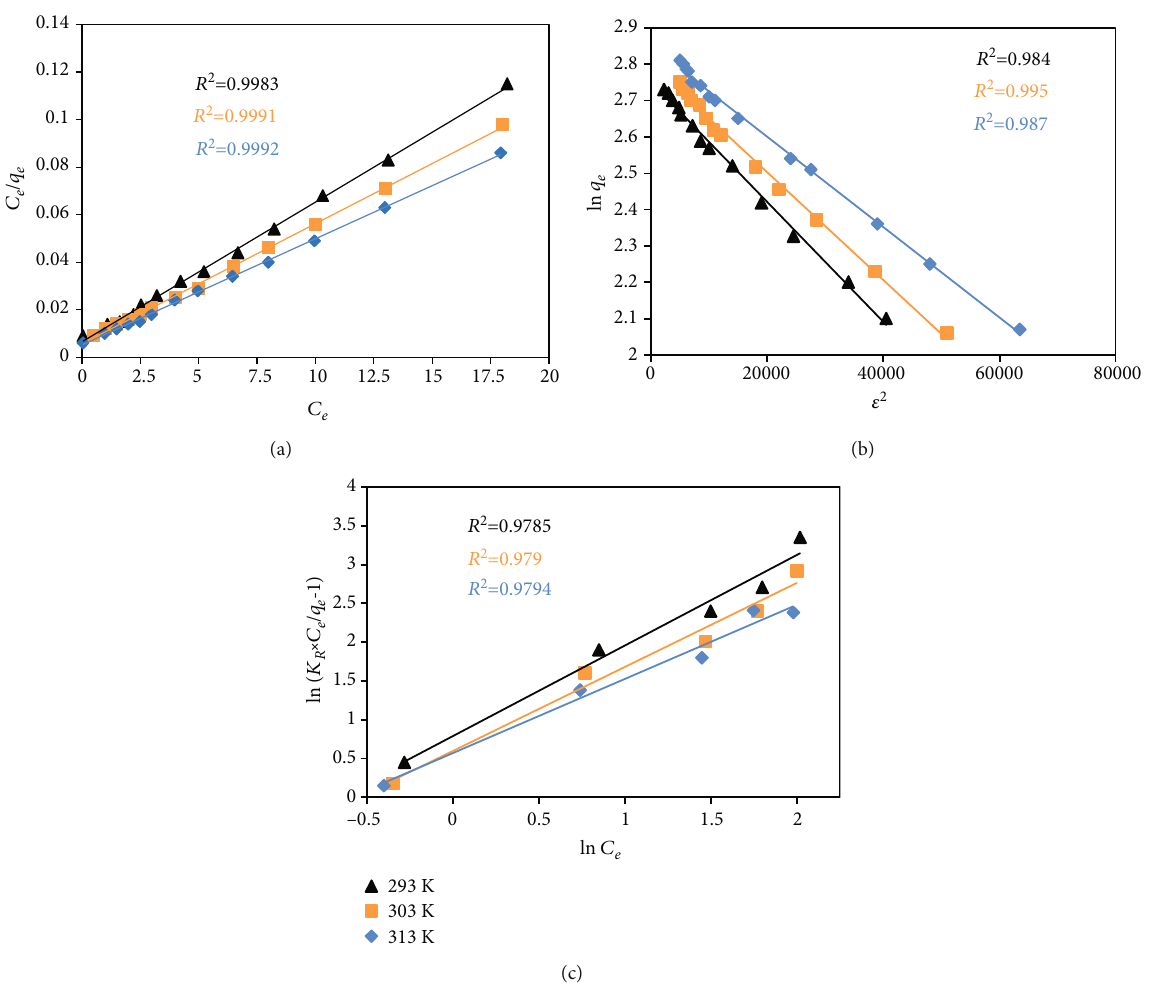
Figure 16: Plot for (a) Langmuir isotherm, (b) D-R isotherm, and (c) Redlich-Peterson isotherm for CV removal onto ACMAS = 25 − 75mg/L ( adsorbent dose = 0 : 15g/L , pH = 6 : 0 , and C 0